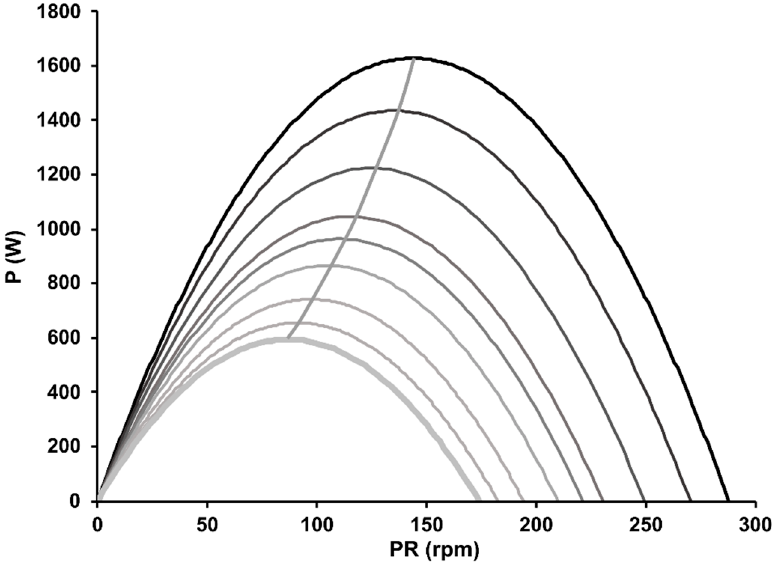
Figure 5. A set of curves illustrating the time-course of the relationship between the force-velocity and power-velocity curves during a 60-s all-out sprint on a cycle ergometer. The profiles were derived from the data at every fifth second of the sprint test shown in Figure 2.